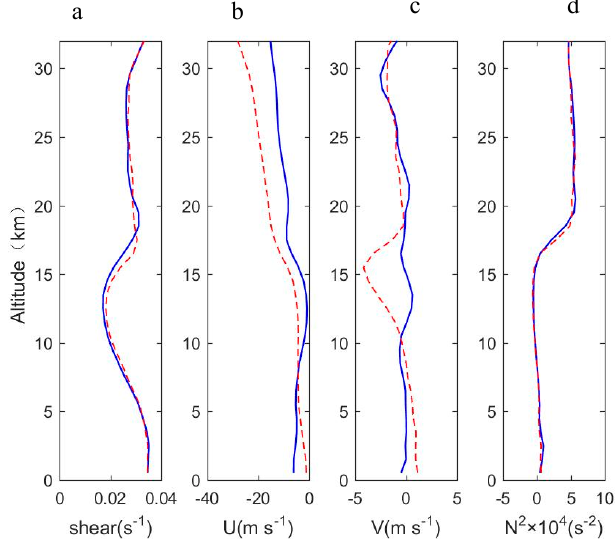
Figure 11. Vertical profiles of ( a ) wind shear, ( b ) zonal wind, ( c ) meridional wind, ( d ) buoyancy frequency (solid blue line: monthly means from 2013 to 2018; red dotted line: the means over six years, from July to September).